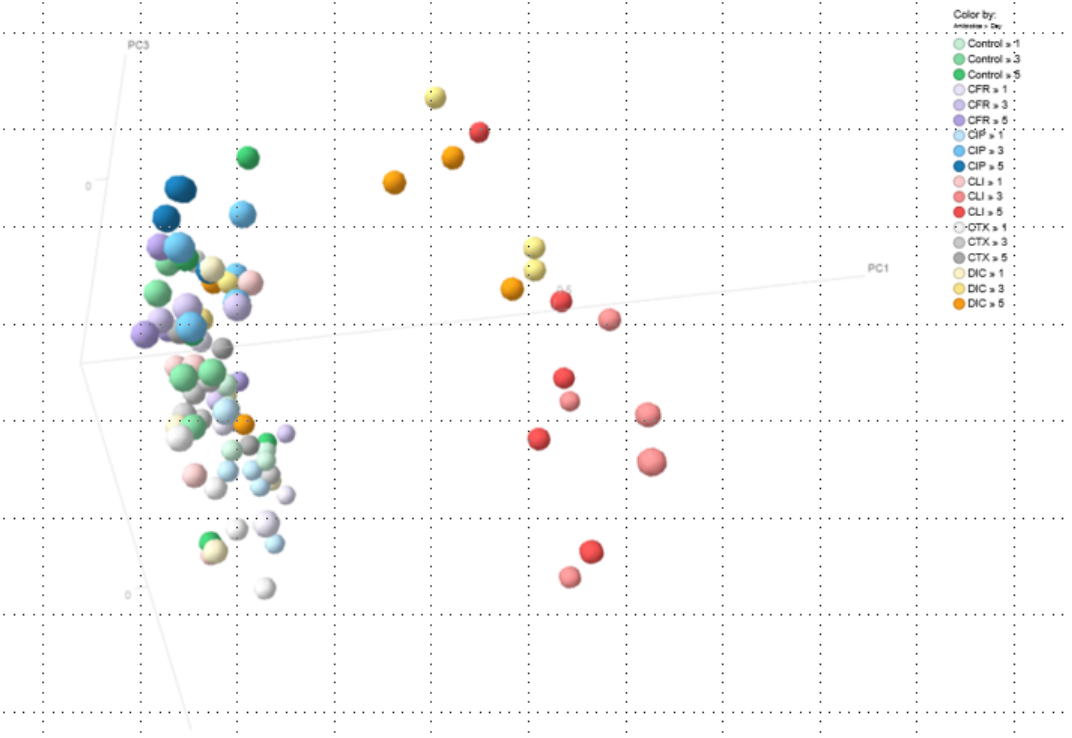
Table 1. P-values for the beta similarity between day 1 (T1) and day 3 (T3), as well as day 1 and day 5 (T5).